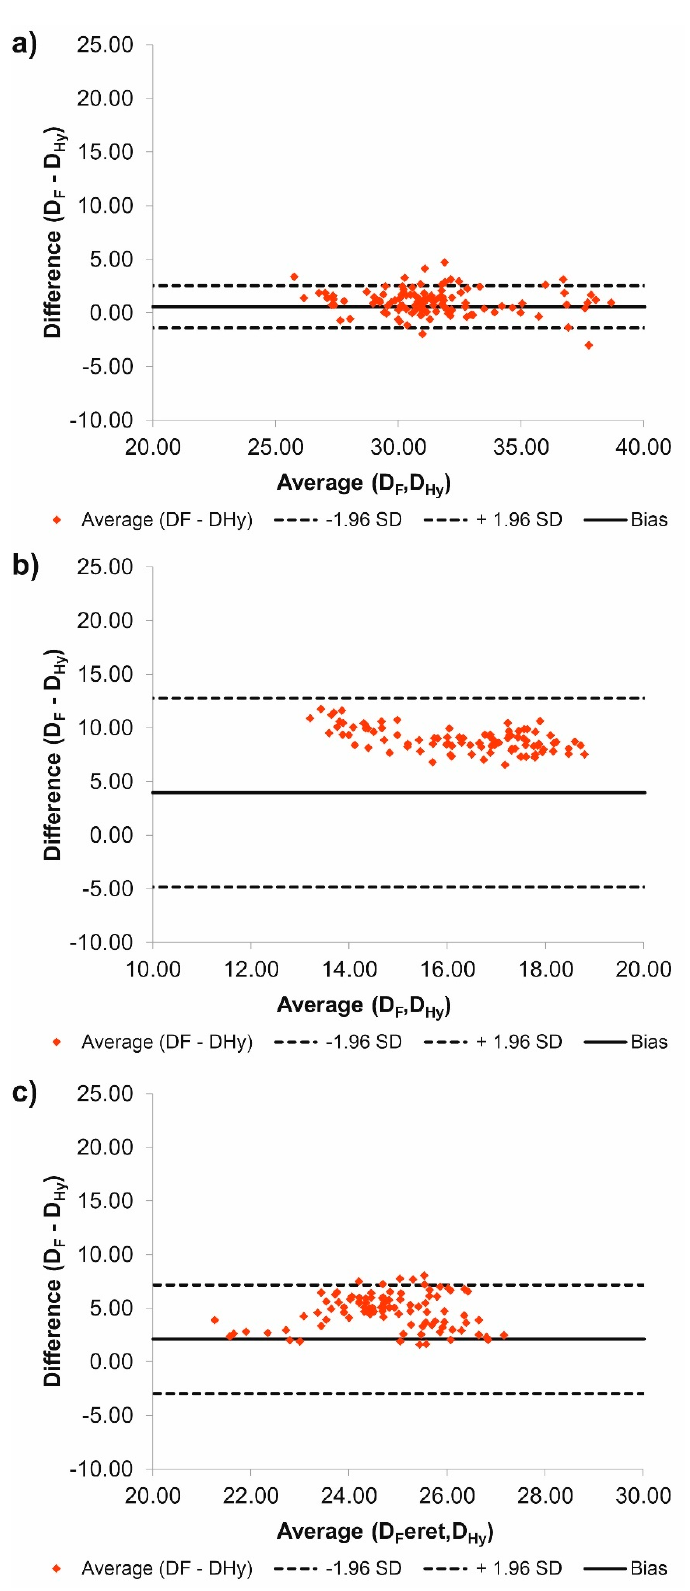
Figure 3. Comparison of D F and D Hy with the use of Bland–Altman analysis for: ( a ) Common duct, ( b ) true duct, and ( c ) false duct. For all analyzes p > 0.05.